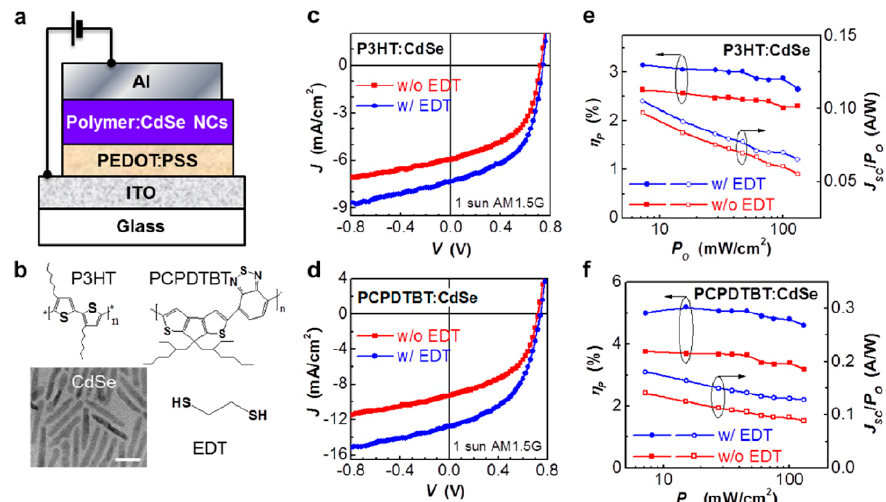
Figure 4. Performance enhancement in polymer: NC hybrid solar cells (HSCs) upon EDT treatment. ( a ) Schematic structure of polymer: NC HSCs. ( b ) TEM image of CdSe nanorods (scale bar: 20 nm)